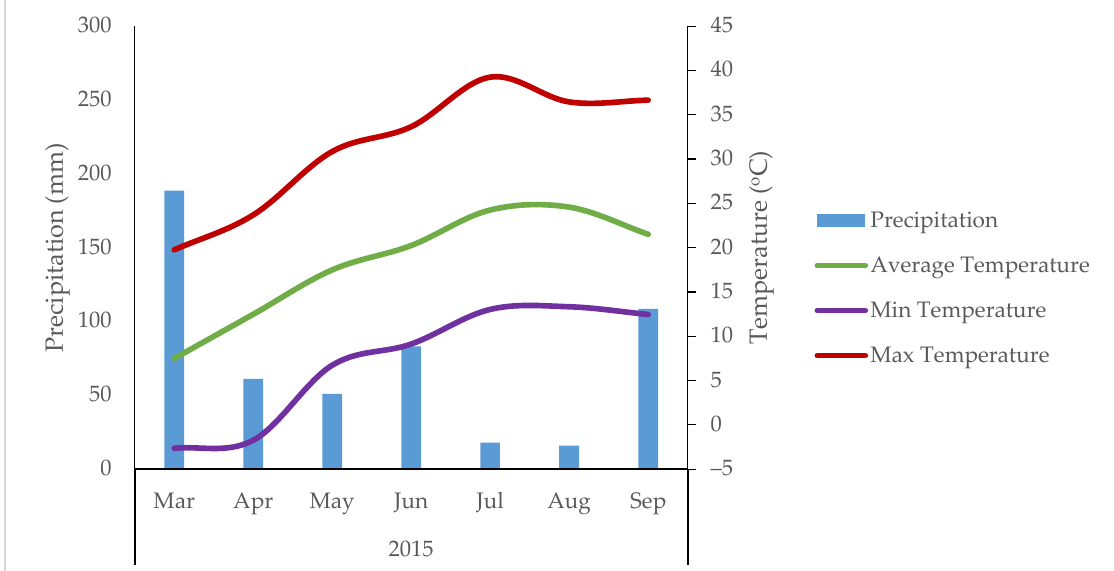
Figure 4. Meteogram of the 2015 vine growing season. Precipitation is expressed monthly, and res- olution of temperature is not precise.